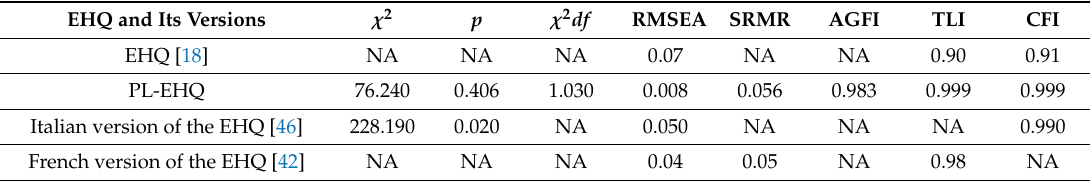
Table 2. Goodness-of-fit indices of the Polish version of the EHQ (PL-EHQ) and its comparison with the original version of the EHQ, as well as with the Italian and French versions of the EHQ. EHQ and Its